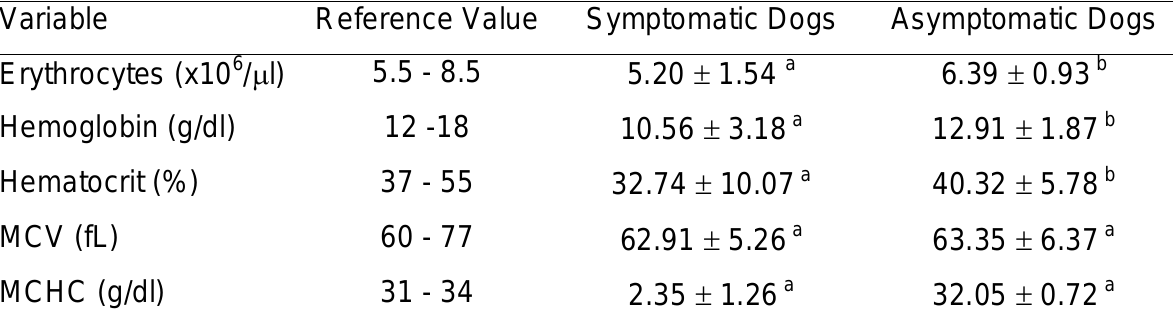
Table 1: Mean and standard deviations of erythrometric variables of symptomatic (n=34) and asymptomatic (n=17) VL seropositive dogs from Teresina, Piauí State, Brazil, 2002.